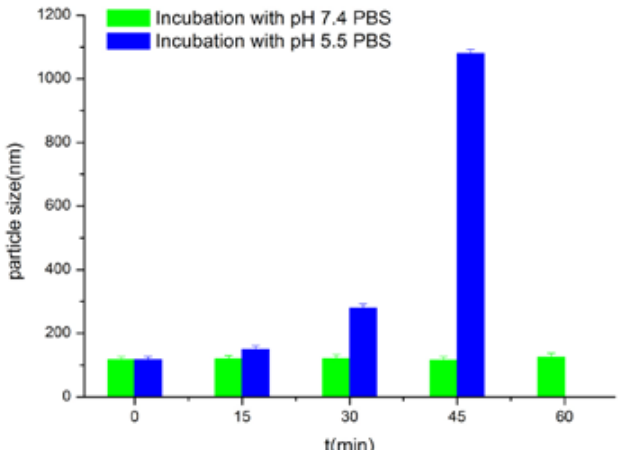
FIGURE 4 - The particle size of 2-ME-PSL incubation with different PBS (n=3).